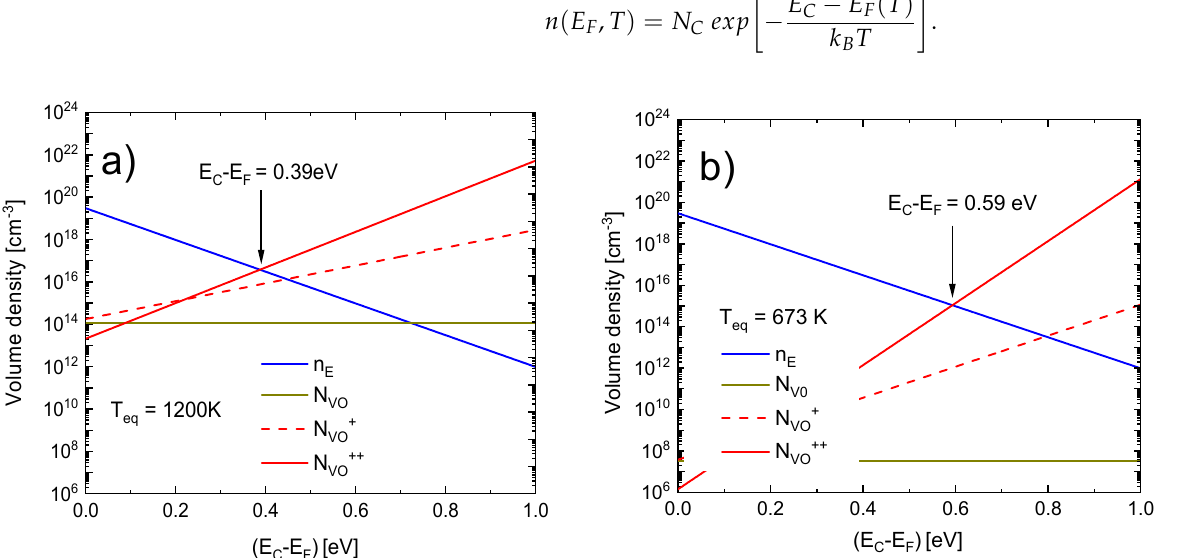
Figure 4. Volume densities of neutral, positively, and twofold positively charged oxygen vacancies as a function of the Fermi-energy inside the forbidden gap ( a ) for a temperature of 1200 K and ( b ) for the chosen sensor operation temperature of 673 K. The blue lines in both sub-figures represent electron concentrations at the conduction band edge.